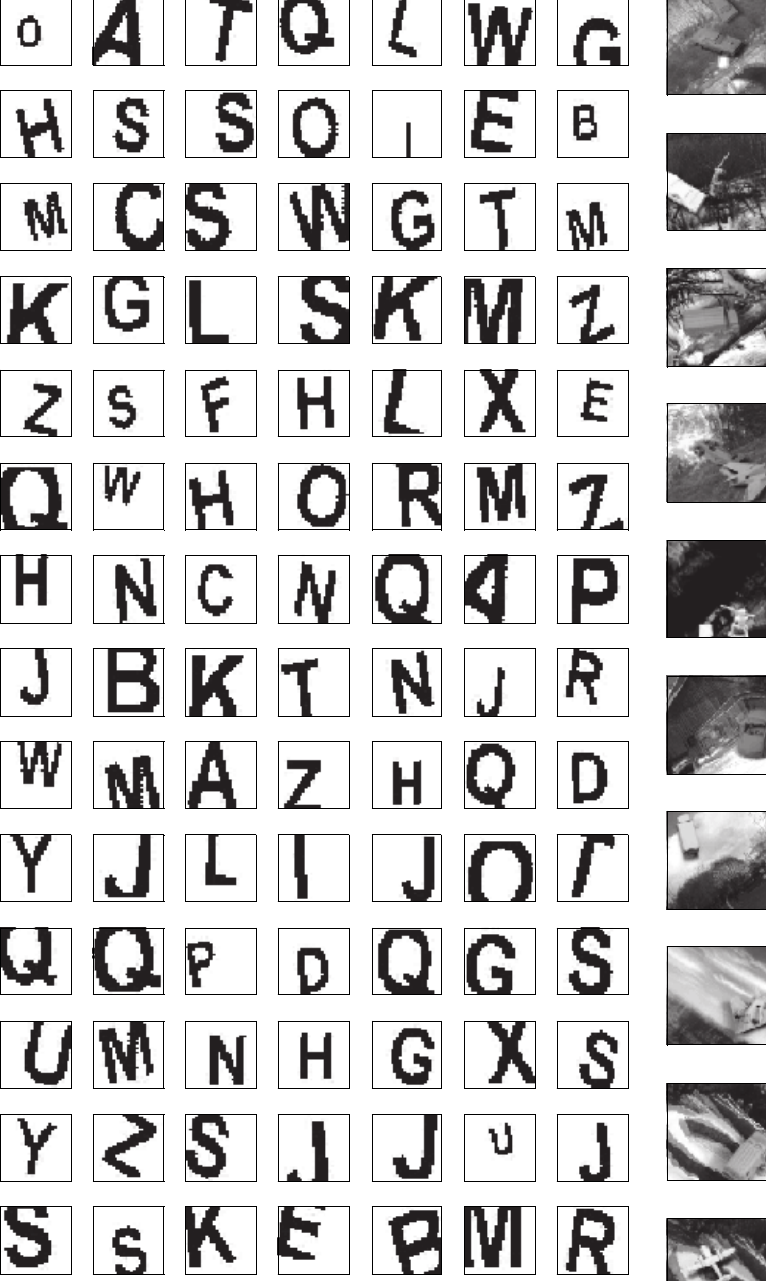
Fig. 2. Less heterogeneousness of the EEACL26 entries in their 26 image categories representing enlarged capital letters of the English alphabet [15]. The background is constantly white, although some grayish pieces appear after downsampling from the original image. Entries of this dataset have all main geometrical attributes of a dataset of real-world images – lines, curves, circles, crosses, roughness, etc. Like entries of CIFAR-10 and NORB, the letters are distorted with shifting, scaling, skewing (rotations), and trimming.